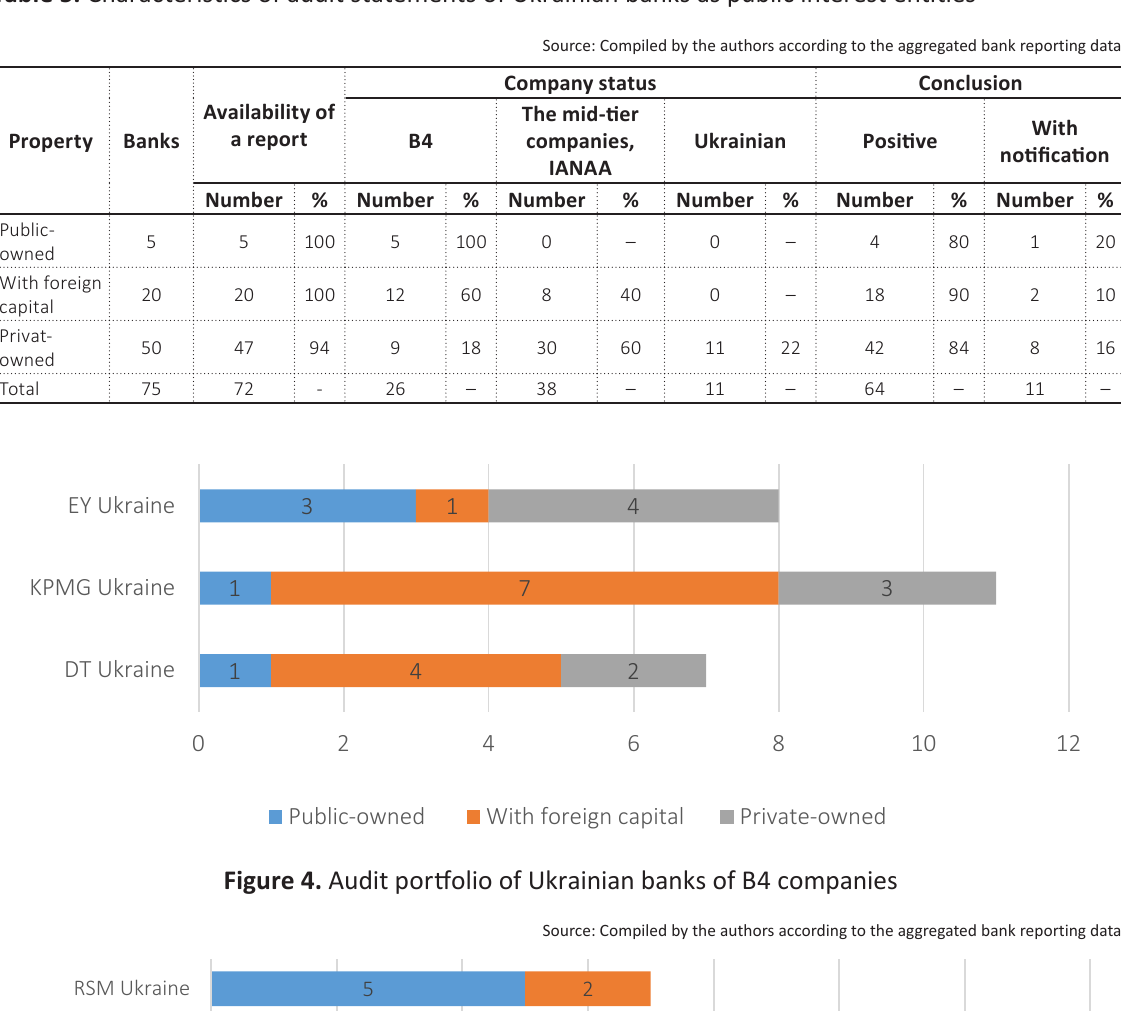
Table 5. Characteristics of audit statements of Ukrainian banks as public interest entities